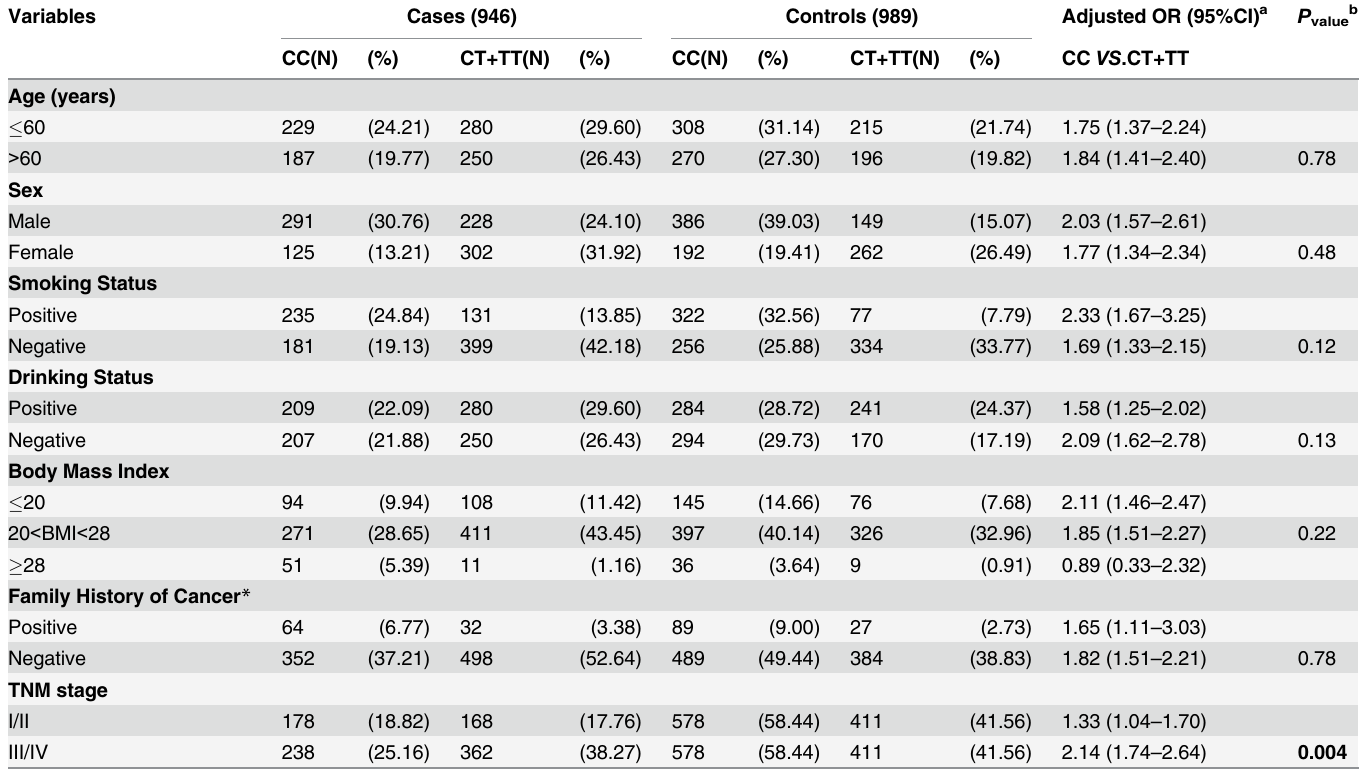
Table 3. Stratified analysis for associations between the CD44 rs13347C/T polymorphism and CRC